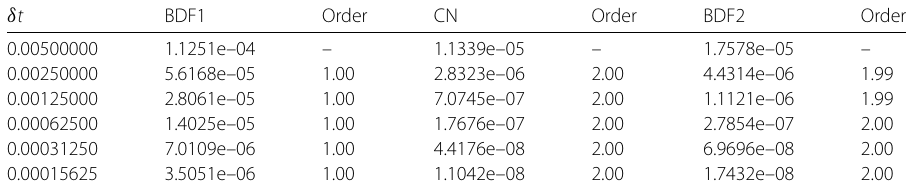
Table 1 The L 2 errors and orders at T = 0.05 for u that are computed by BDF1, CN, and BDF2 schemes δ t